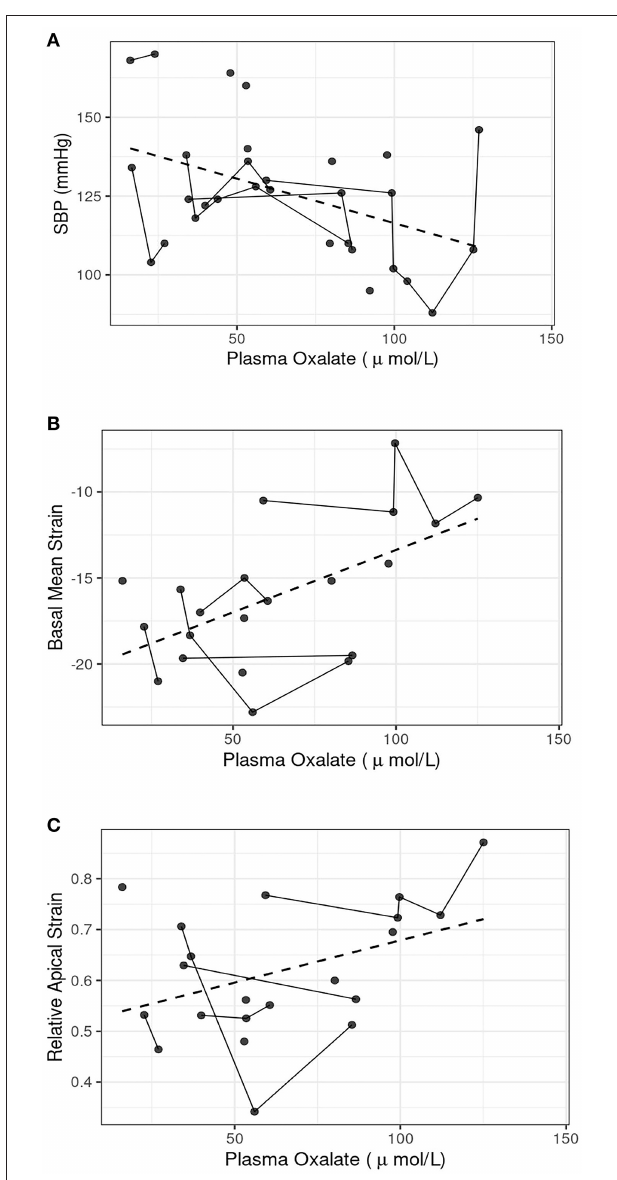
FIGURE 5 | Regression models of selected markers of cardiac function as a function of pOx. Dashed line represents a simple linear regression fit. (A) Systolic blood pressure: Systolic blood pressure decreased at higher pOx, p < 0.05, n = 30 readings in 13 subjects. (B) Basal mean strain: Mean longitudinal strain of the basal segments of the LV plus RV worsened at higher pOx, p < 0.05, n = 21 readings in 10 subjects. (C) Relative apical strain: Trend toward apical sparing, p = 0.070, n = 21 readings in 10